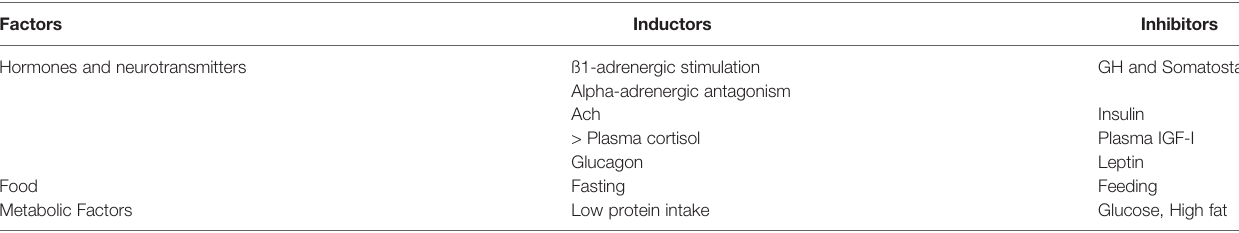
TABLE 1 | Main factors involved in the regulation of the gastric secretion of ghrelin.